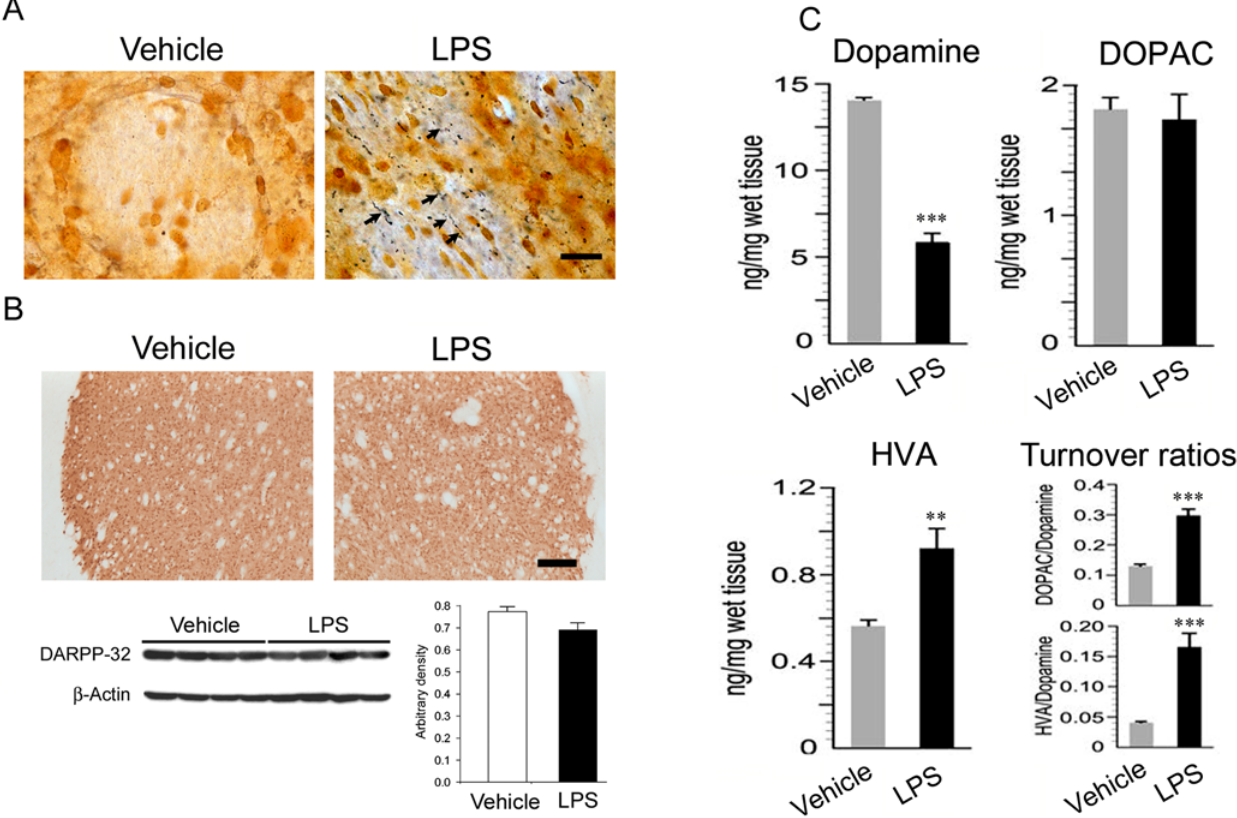
Figure 2. Axonal terminal degeneration in the striatum following intrastriatal LPS. (A) Silver staining reveals that there is no silver-positive stained fibers in the vehicle treated striatum while an abundance of silver grain-deposits are observed in the LPS injected striatum, suggesting the degeneration of axonal fibers (arrows). Scale bar: 20 m m. (B) Immunostaining for DARPP-32 shows that the GABAergic neurons are intact following LPS injections. Western blot for DARPP-32 and its quantification indicate that there is no significant alteration in the expression of DARPP-32 after LPS challenge. Scale bar: 200 m m. (C) HPLC analysis shows that intrastriatal LPS injection depletes 58% of the striatal dopamine relative to control at four weeks. The DOPAC level is not affected; however, HVA is significantly increased. The turnover ratios of DOPAC/dopamine and HVA/dopamine are dramatically increased (n=7/group; ** p , 0.01, *** p , 0.001).